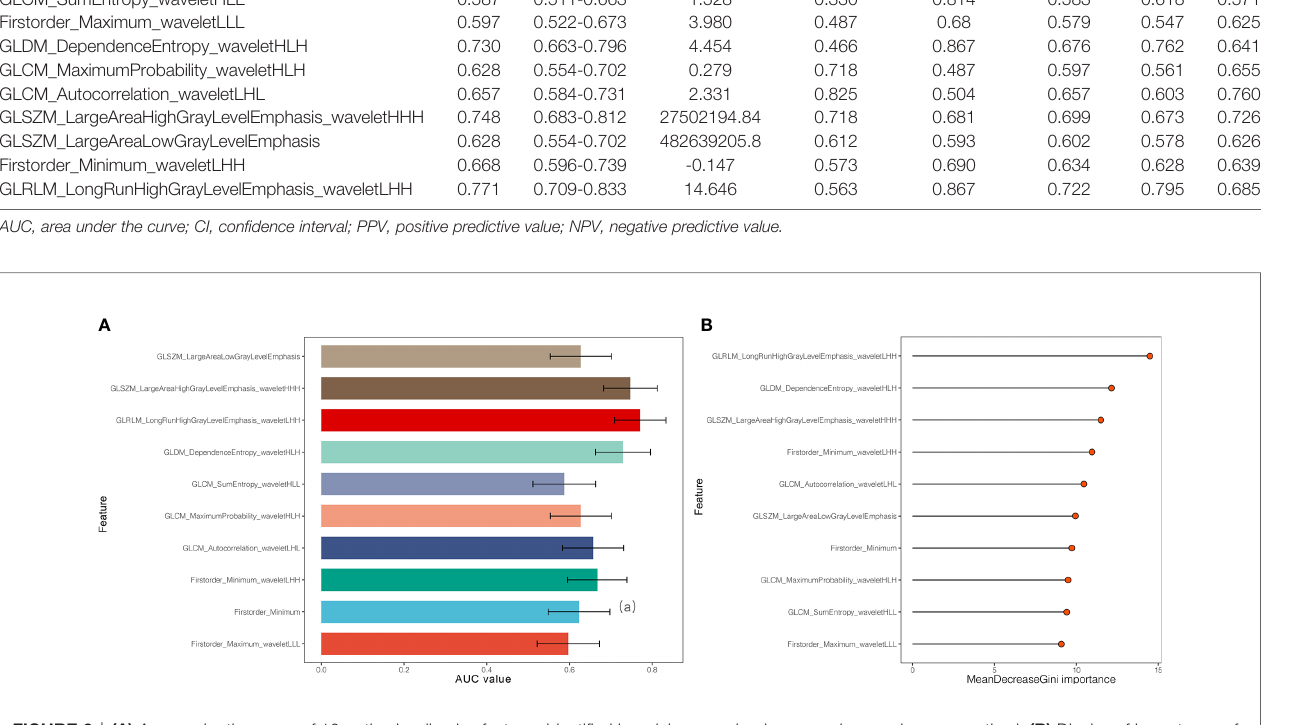
FIGURE 3 | (A) Area under the curve of 10 optimal radiomics features identi fi ed by minimum redundancy maximum relevance method. (B) Display of importance of 10 optimal radiomics features in random forest classi fi er built in the full